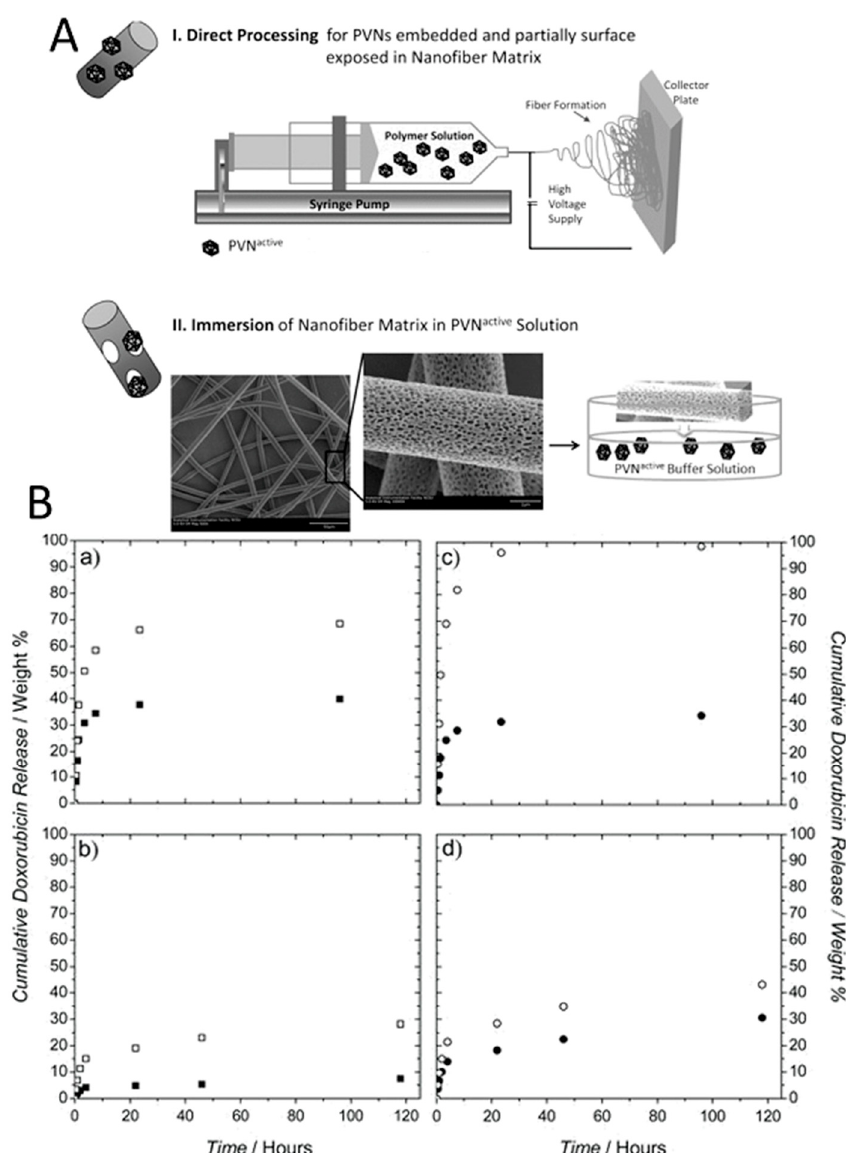
Figure 7. ( A ) Schematic of processes for incorporating plant viral nanoparticles (PVN) in nanofiber matrices. In the direct processing method (I), the PVN active are electrospun in situ with the polymer solution. In the immersion process (II), the nanofiber matrices are dipped into a specific volume and concentration of PVN active particles. (Scale bars of the images from left to right 50.0 µ m and 2.0 µ m, respectively) ( B ) Cumulative doxorubicin release over time of PLA nanofiber matrices combined with PVN Dox ( (cid:4) ) or free doxorubicin ( (cid:3) ) where PLA was combined with the active either a) post mat fabrication (dipping method) or b) prior to electrospinning (co-spinning method) and of 70:30 PLA:PEO nanofiber matrices with PVN dox (o) or free doxorubicin ( (cid:8) ) where PLA:PEO was combined with the active either c) post mat fabrication (dipping method) or d) prior to electrospinning